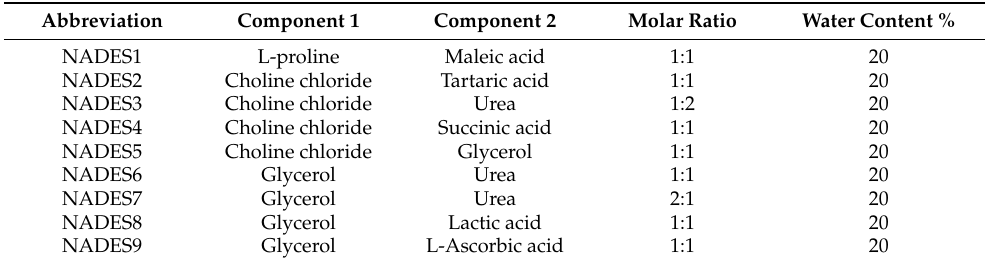
Table 1. The composition of the Natural Deep Eutectic Solvents (NADESs) used in the present study and their